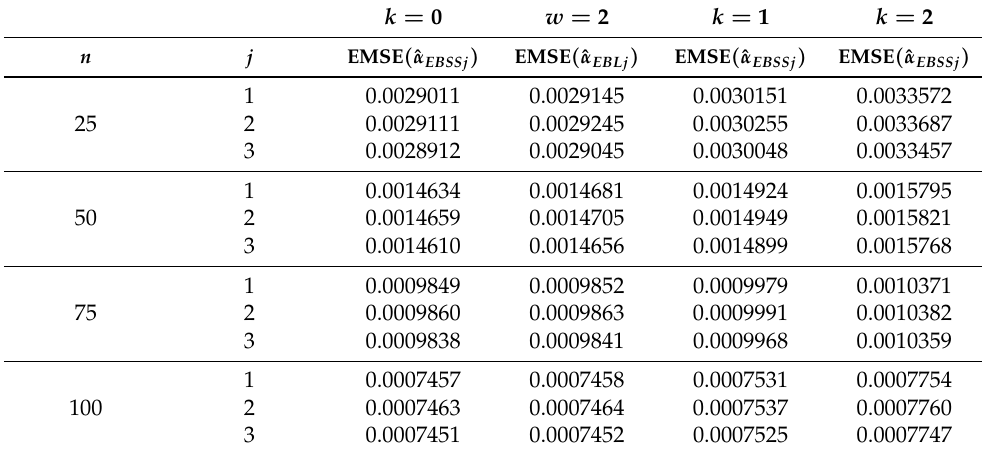
Table A4. Simulated EMSE of ˆ α with s = 0.9, β = 0.9, u = 4 and v = 5.